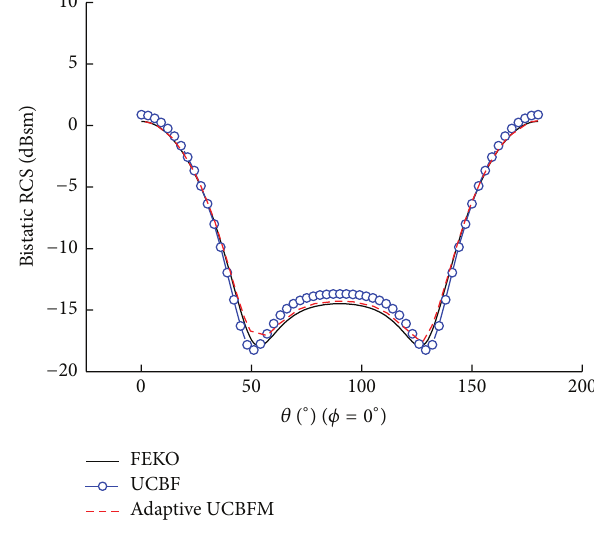
Figure 2: Bistatic RCS of PEC plate at 1.5GHz.